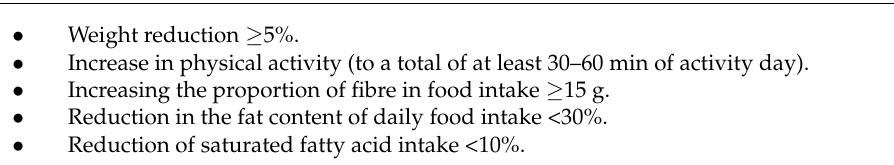
Table 2. Lifestyle intervention targets.